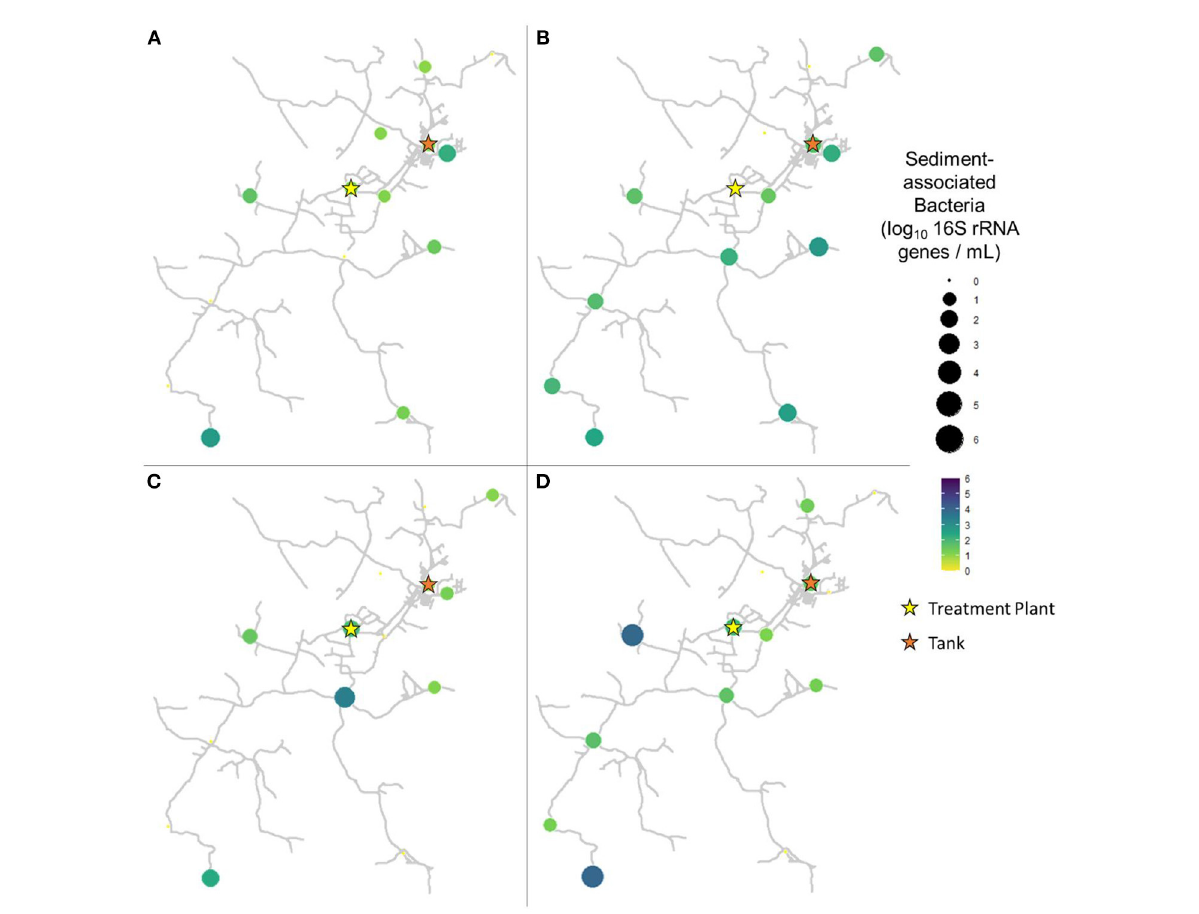
FIGURE4 Particle-associated bacteria in samples collected at all sites in (A) March (2 weeks before flushing), (B) April (1 week after flushing), (C) June (9 weeks after flushing), and (D) August (16 weeks after flushing).